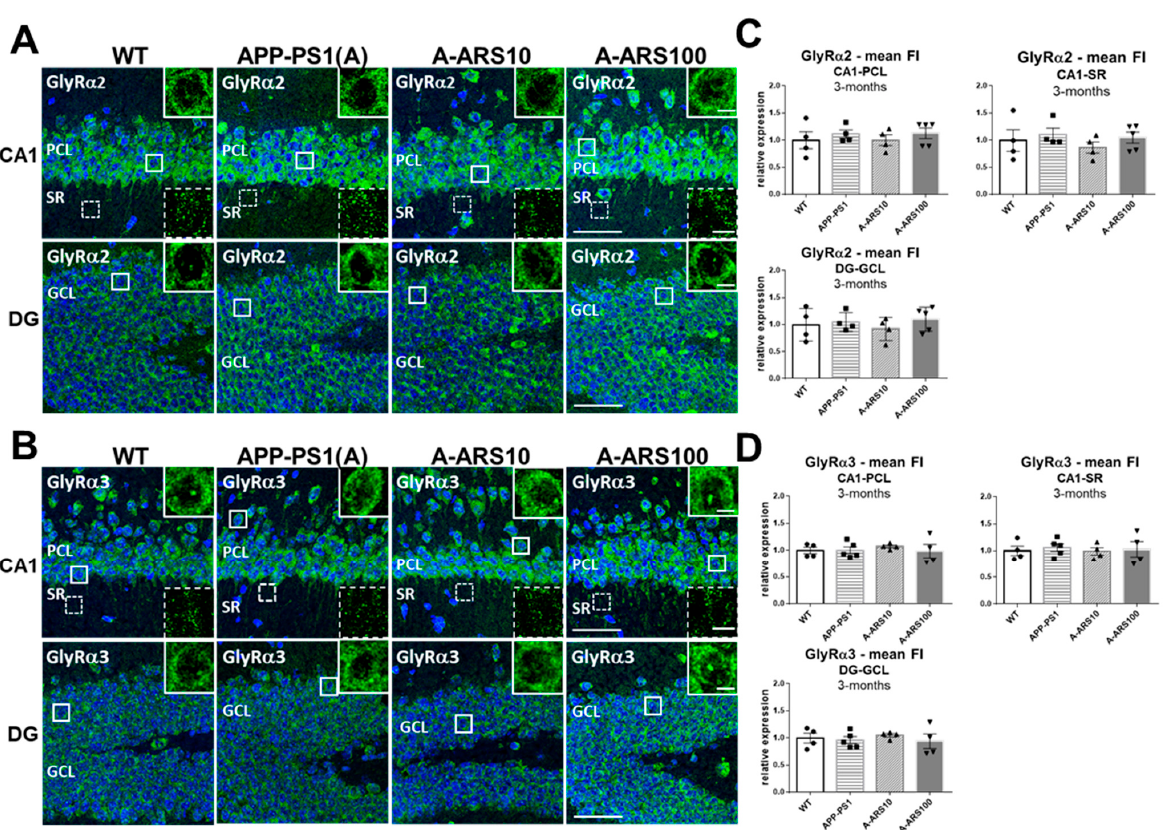
Figure 1. Level and regional distribution of GlyR α 2 and GlyR α 3 immunoreactivities in hippocam- pus sections of 3-month-old WT and APP/PS1 mice. ( A , B ) Representative IF images from brain cryosections of WT, APP/PS1 and APP/PS1 mice treated with two different doses (10 mg/kg and 100 mg/kg) of artesunate (A-ARS10, A-ARS100), labeled with subtype-specific antibodies for GlyR α 2 ( A ) and GlyR α 3 ( B ). Cell nuclei were revealed by 4 ′ ,6-diamidino-2-phenylindole (DAPI) staining. Similar staining patterns and regional distribution of GlyR α 2 ( A ) and GlyR α 3 ( B ) immunoreactivities can be seen in the CA1 region and the dentate gyrus (DG) of the hippocampus of young WT and APP/PS1 mice, as well as APP/PS1 mice treated with ARS. Both GlyR subtypes are enriched in the pyramidal cell layer (PCL) of CA1 and the granule cell layer (GCL) of DG. Only rather weak GlyR α 2 ( A ) and GlyR α 3 ( B ) immunostaining can be seen in the stratum radiatum (SR) of CA1. Insets show magnifications of the boxed windows in the PCL and SR of the CA1 region and GCL of the dentate gyrus, respectively. They show intense punctate GlyR α 2 ( A ) and GlyR α 3 ( B ) staining at the soma of CA1 pyramidal cells, DG granule cells and GlyR-positive clusters of different sizes within the SR of the CA1 region, respectively. Confocal maximum intensity projections (8 optical sections, 3.5-µm thick z-stack; insets showing cells—2 optical sections, 1-µm thick z-stack); scale bars: 50 µm; insets: 10 µm. ( C , D ) Quantification of GlyR α 2 ( C ) and GlyR α 3 ( D ) immunoreactivities in the PCL and SR of the CA1 region and GCL of the dentate gyrus of WT and APP/PS1 mice. Three randomly chosen fields within CA1 and two in the DG of each hippocampus were analyzed. n = 4–5 animals/group; means ± SEM of mean fluorescence intensities (FI).